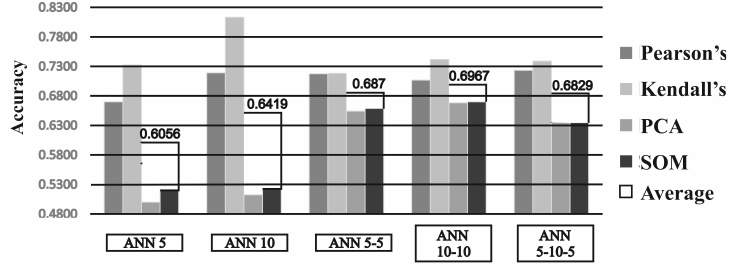
Figure 5. Comparison of best test set accuracies of different ANN topologies.